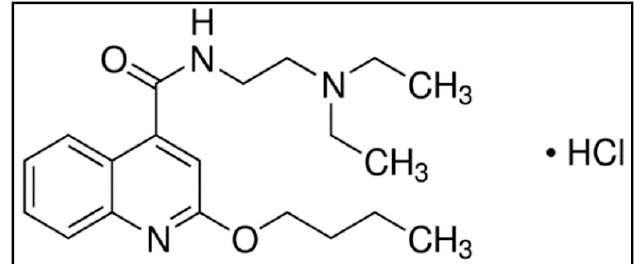
Figure 1. The chemical structure of dibucaine hydrochloride.